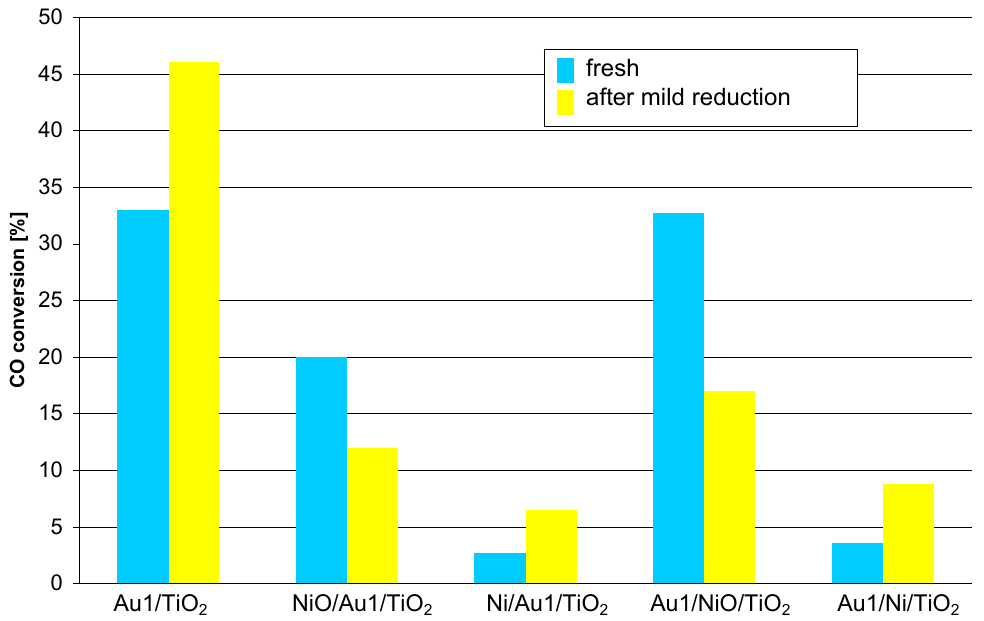
Figure 2. Catalytic activity at 35 °C measured for catalysts differing in the sequence of gold and nickel compound deposition and in the preparation atmosphere (oxidizing or reducing). Reaction conditions: contact time: 0.36 s, feed composition CO:O